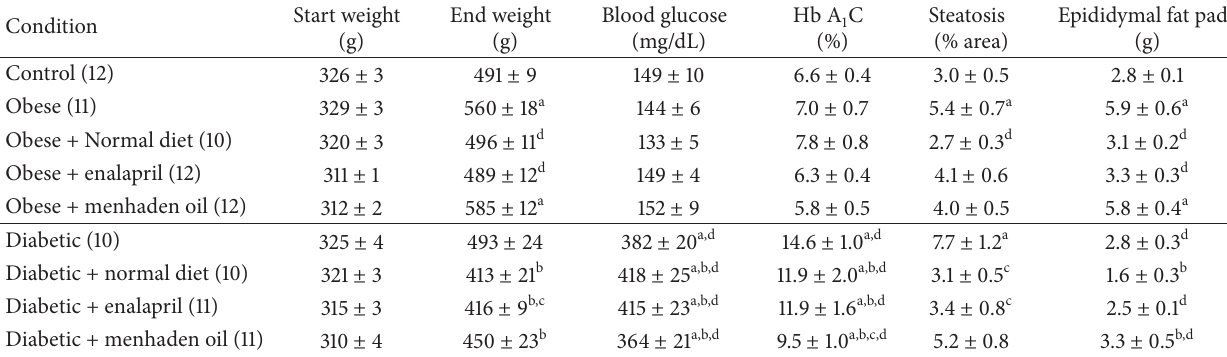
Table 1: Effect of reversal of high fat diet, enalapril, or menhaden oil in diet-induced obese or type 2 diabetic rats on change in body weight, nonfasting blood glucose, hemoglobin A